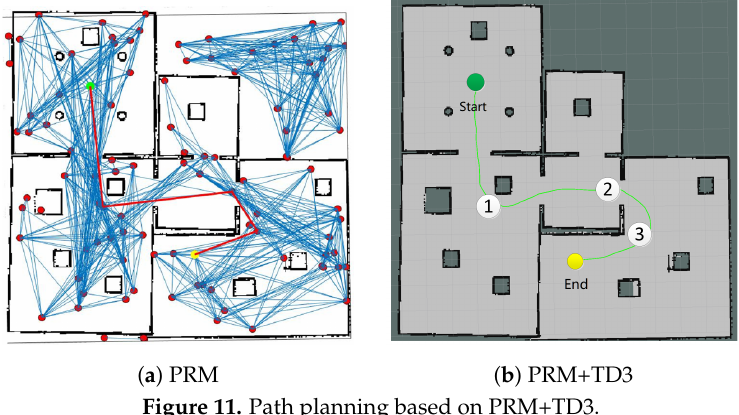
Figure 11. Path planning based on PRM+TD3.